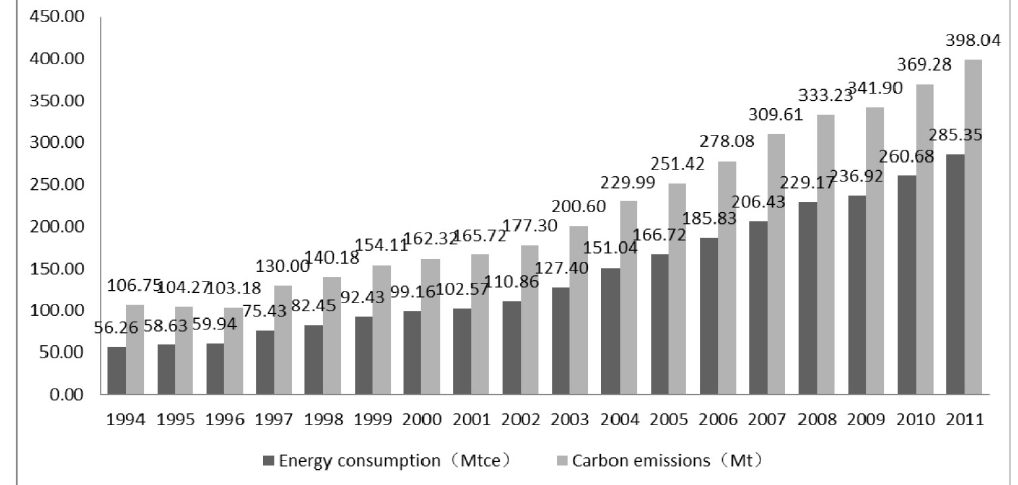
Figure 2. Energy Consumption and Carbon Emissions of China’s Transportation Industry 1994-2011